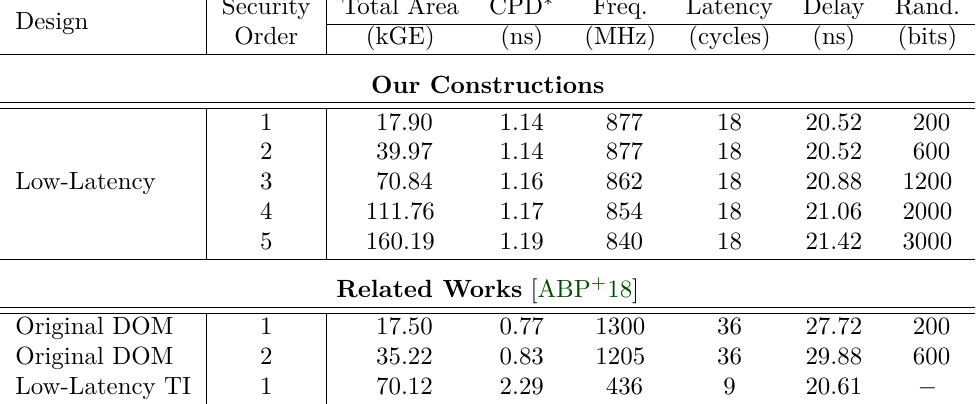
Table 3: Synthesis result of different Keccak- f [200] designs, using NanGate 45 nm standard cell